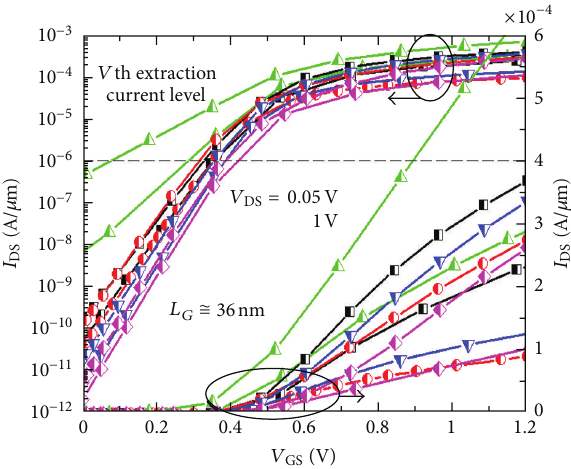
Figure 3: Comparison of bFDSOI and SOI MOSFETs 𝐼 characteristics with gate length 𝐿 𝐺 = 36 nm. The symbols are the same as in Figure 2.